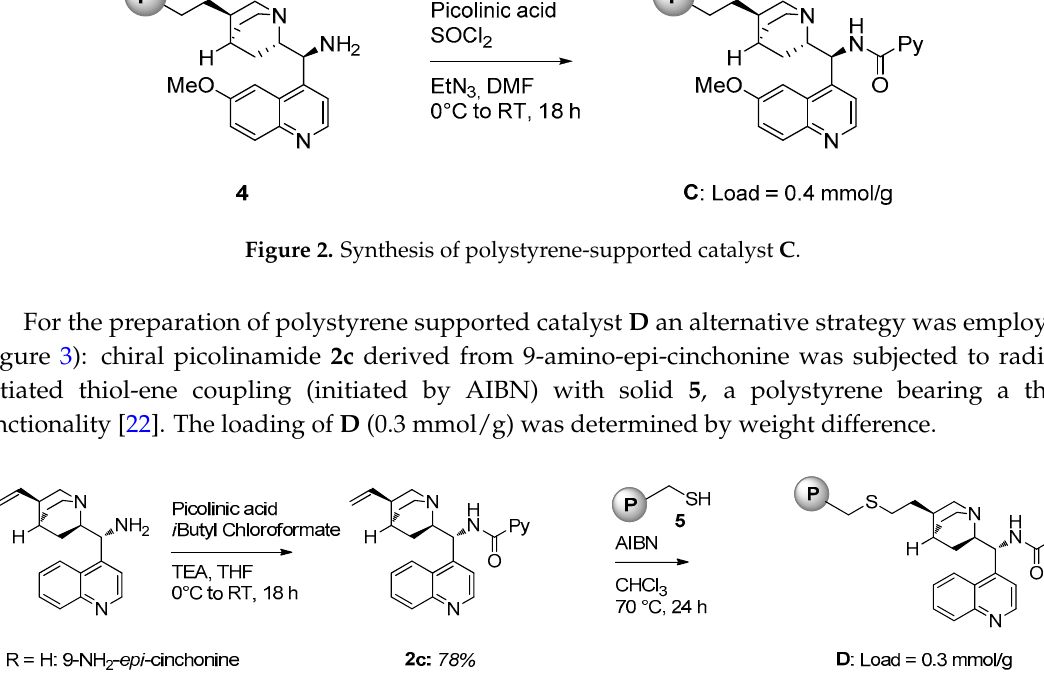
Figure 3. Synthesis of polystyrene-supported catalyst D .